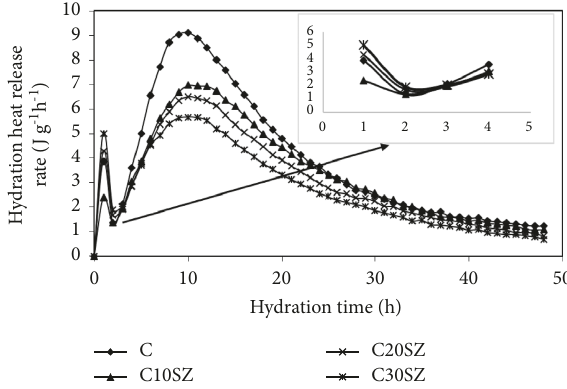
Figure 2: Hydration heat released rate of the Portland cement samples without and with SZ.